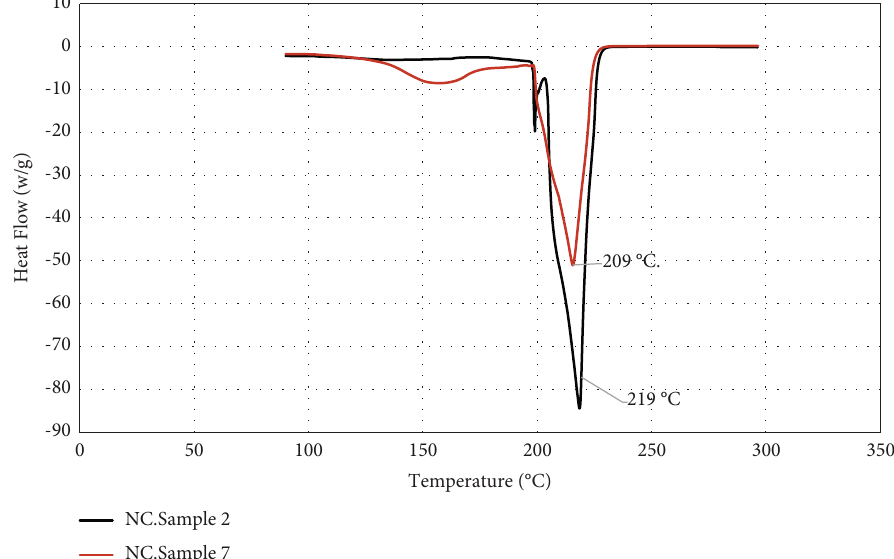
Figure 6: Diferential scanning calorimetry (DSC) analysis two nanocellulose samples after enzymatic hydrolysis, that showing two peaks typical of nanocellulose. source: author himself.